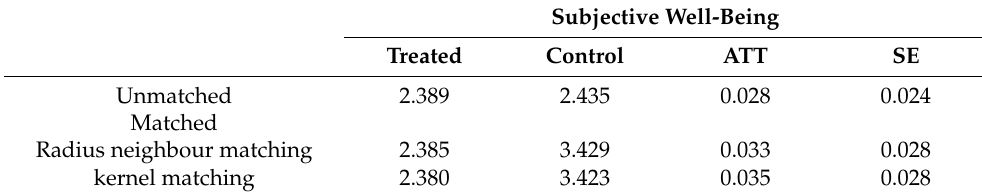
Table 7. Results of PSM estimation.